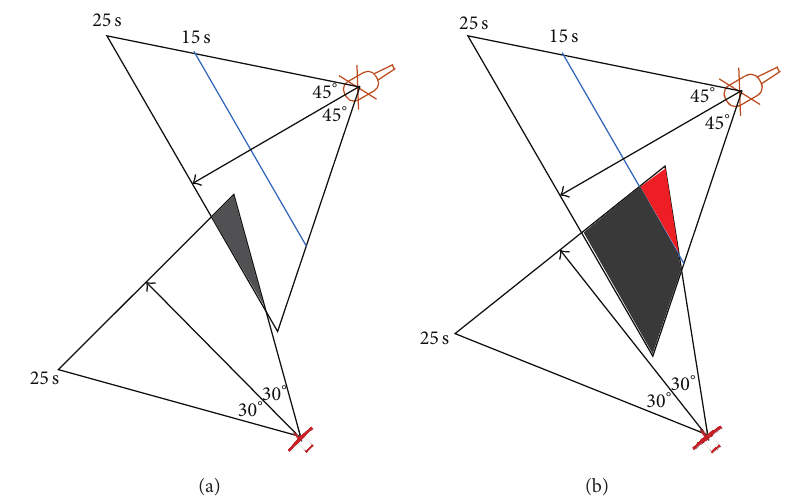
Figure 11: Advisories (a) TA and (b) RA by TSR algorithm.